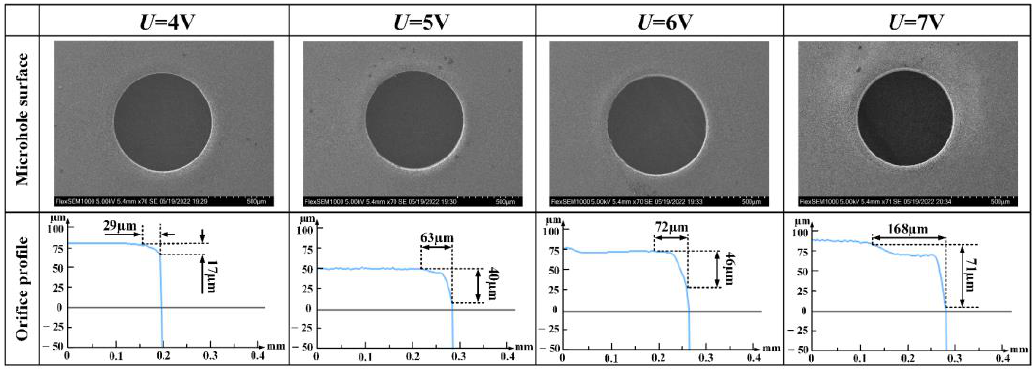
Figure 18. Influence of machining voltage on orifice chamfer.